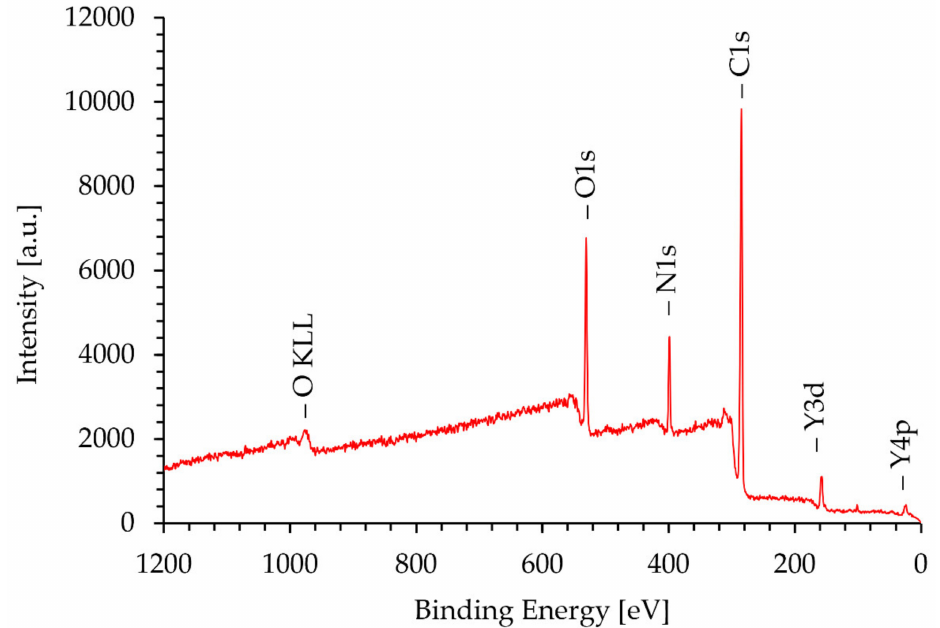
Figure 8. XPS spectrum of the concentrated sample Ni/Y 2 O 3 -0.025/0.100